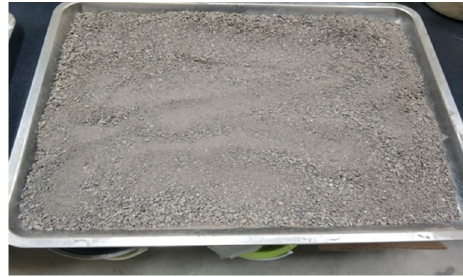
Figure 2. The appearance of stone